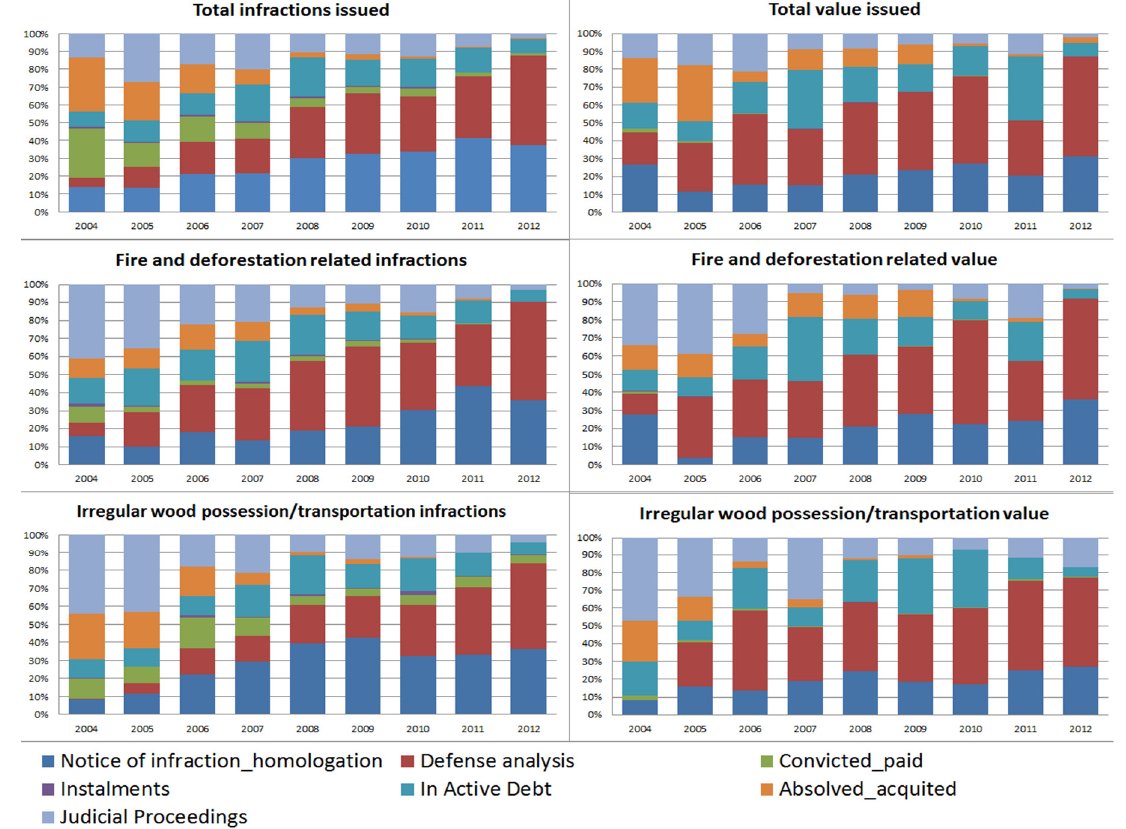
Figure 5. Collection of fines issued in the period 2004–2012.